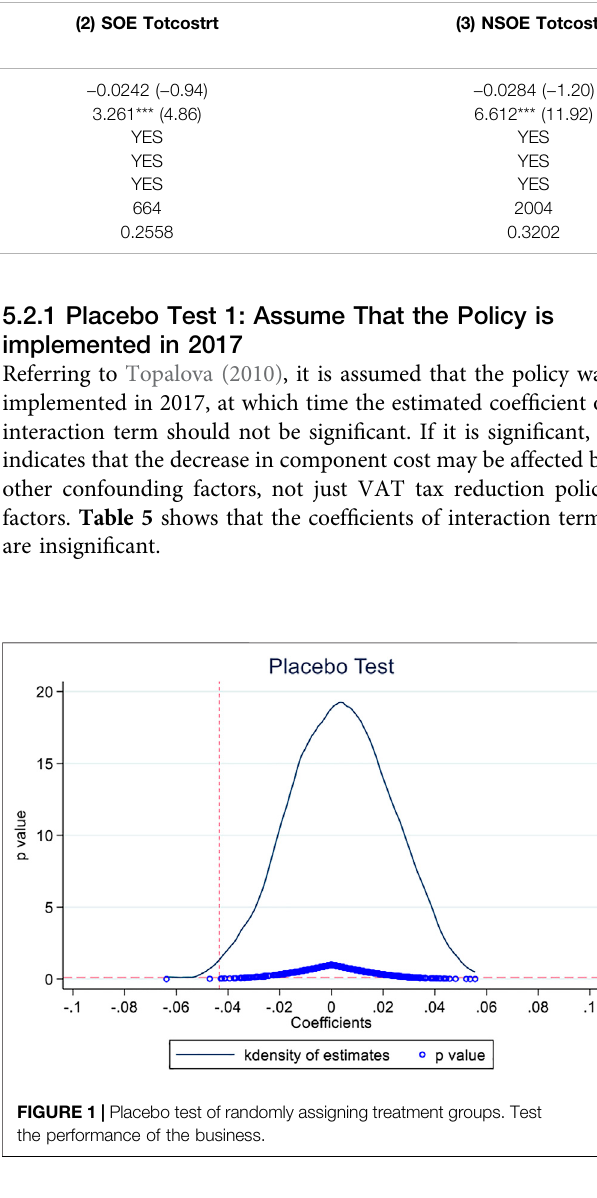
TABLE 5 | Placebo test results ( fi ctitious implementation time).